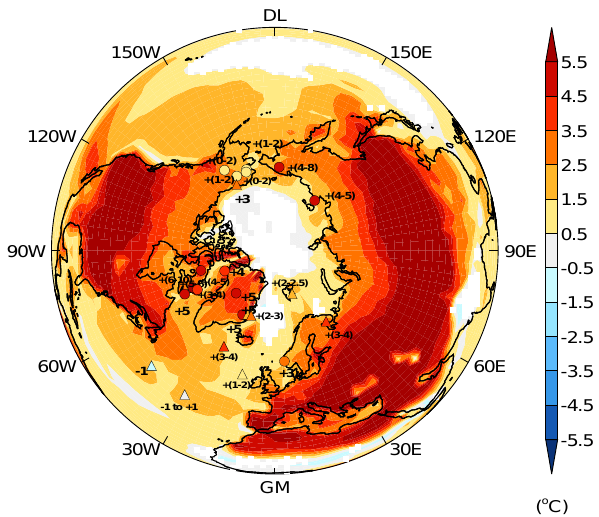
Fig. 5. Simulated maximum LIG Arctic summer (June, July, Au- gust) temperature anomaly relative to the pre-industrial period. Overlain is the maximum observed LIG summer temperature anomalies from palaeotemperature proxies (terrestrial (circles) and marine (triangles)) (CAPE members, 2006; Kaspar et al., 2005). White regions are not statistically significant (at the 95% confi- dence